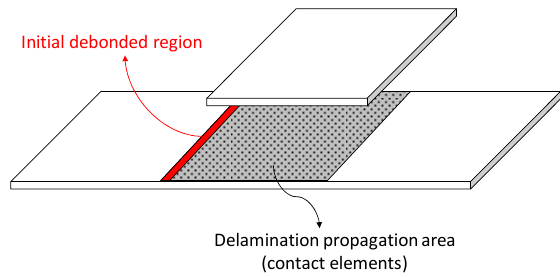
Figure 6. Delamination propagation area modeling.